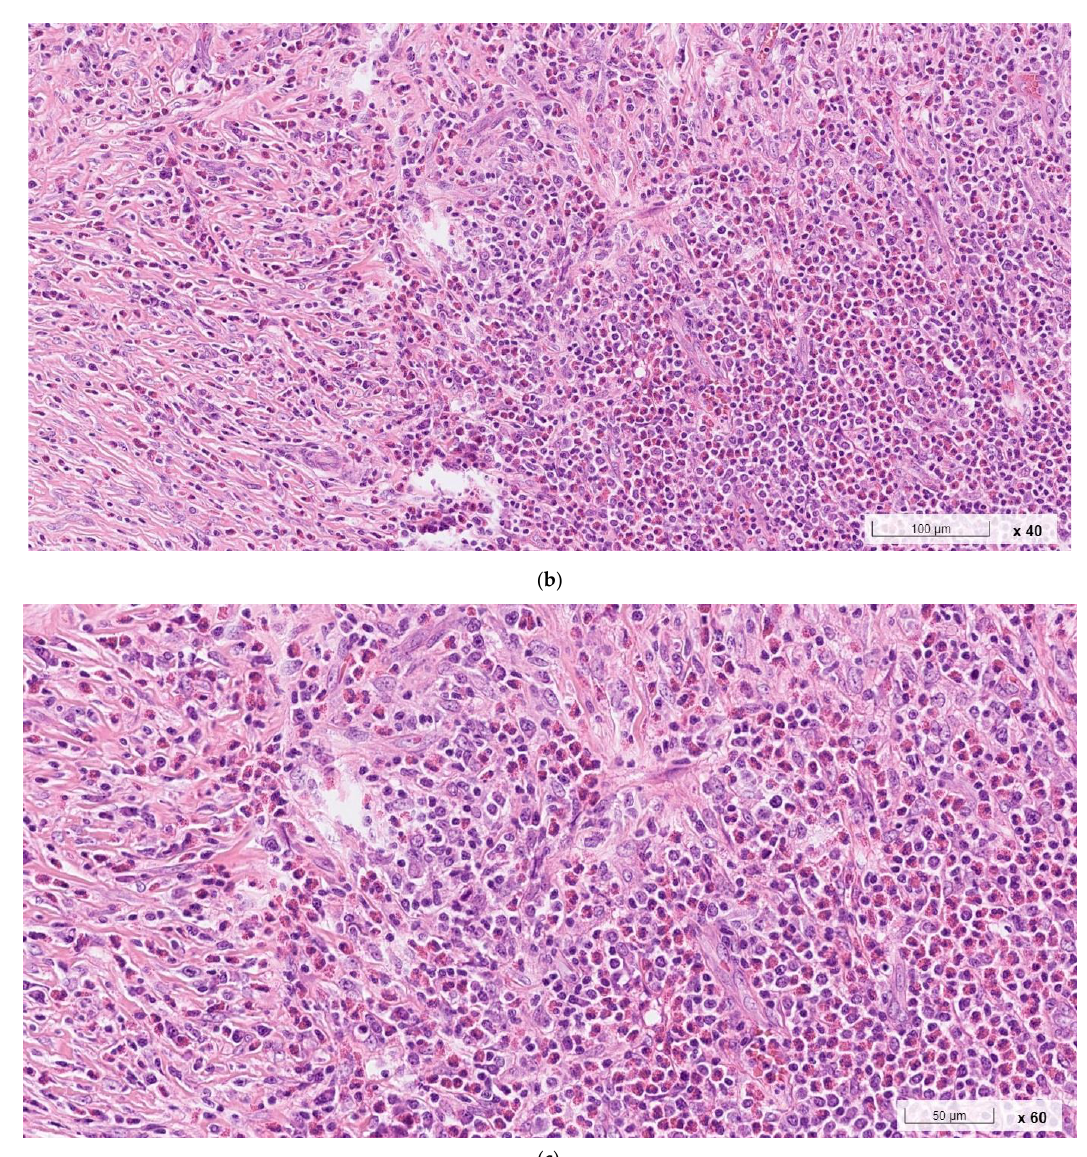
Figure 1. Histopathological examination of an enlarged right cervical lymph node; collected via complete surgical resection at our institution. ( a – c ): Hematoxylin–eosin staining showed the follic- ular hyperplasia of the lymphoid tissue with well-formed germinal centers, interfollicular dense eosinophilic infiltrates, eosinophilic microabscesses, vascular proliferation, and prominent intersti- tial fibrosis.